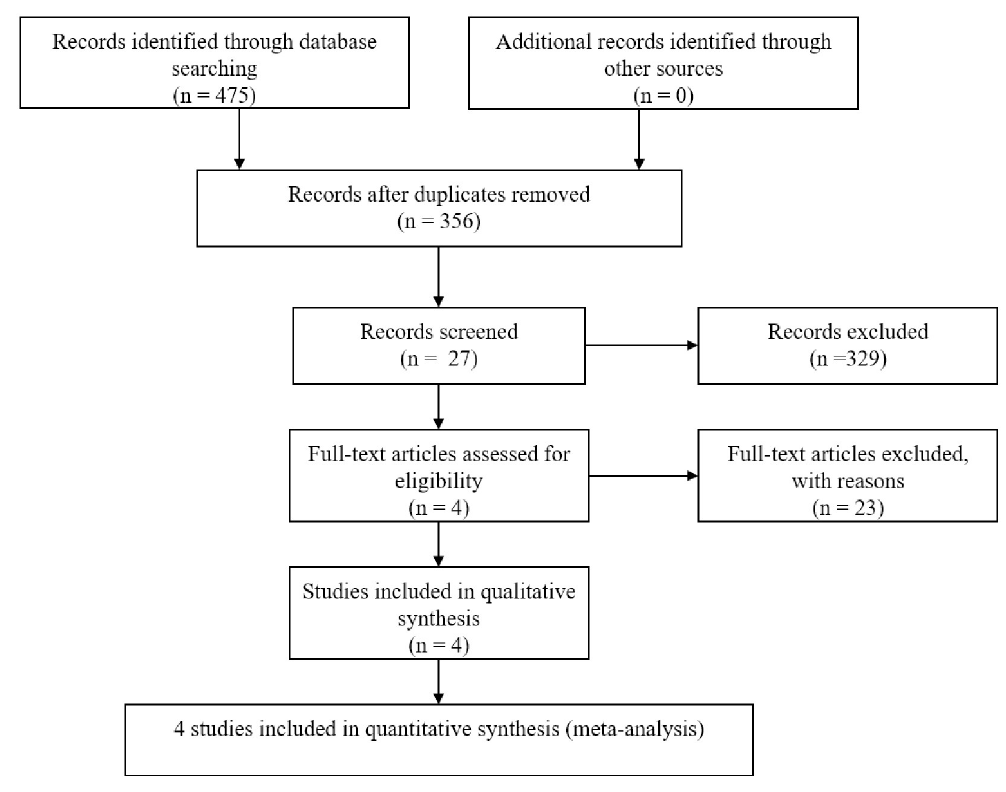
Fig 1. Flow diagram of the study selection process.